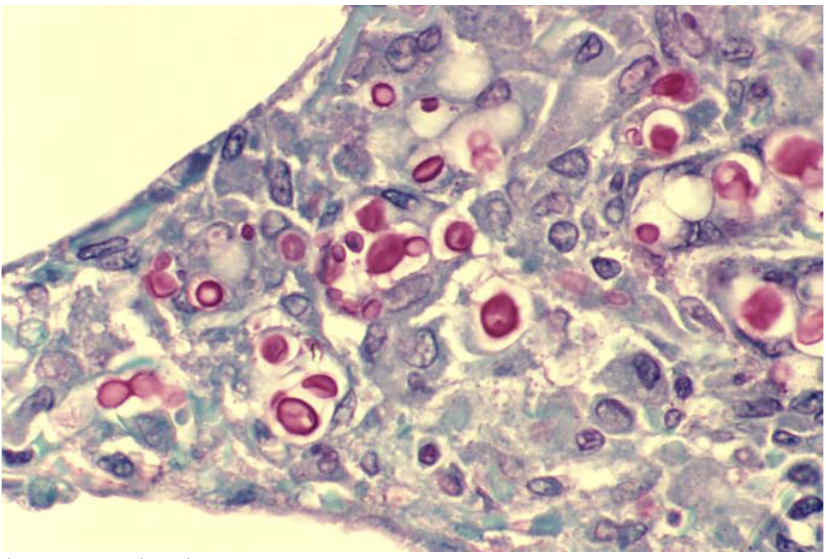
Figure 1. Cryptococcosis of the Lung in a Patient with AIDS Histopathology of lung shows widened alveolar septa containing a few infl ammatory cells and numerous yeasts of the fungal pathogen C. neoformans . The inner layer of the yeast capsule stains red. Cryptococcosis is transmitted through inhalation of airborne yeast cells and/or biospores. At risk are the immunocompromised, especially those with HIV infection. Photo: CDC/Dr. Edwin P. Ewing,